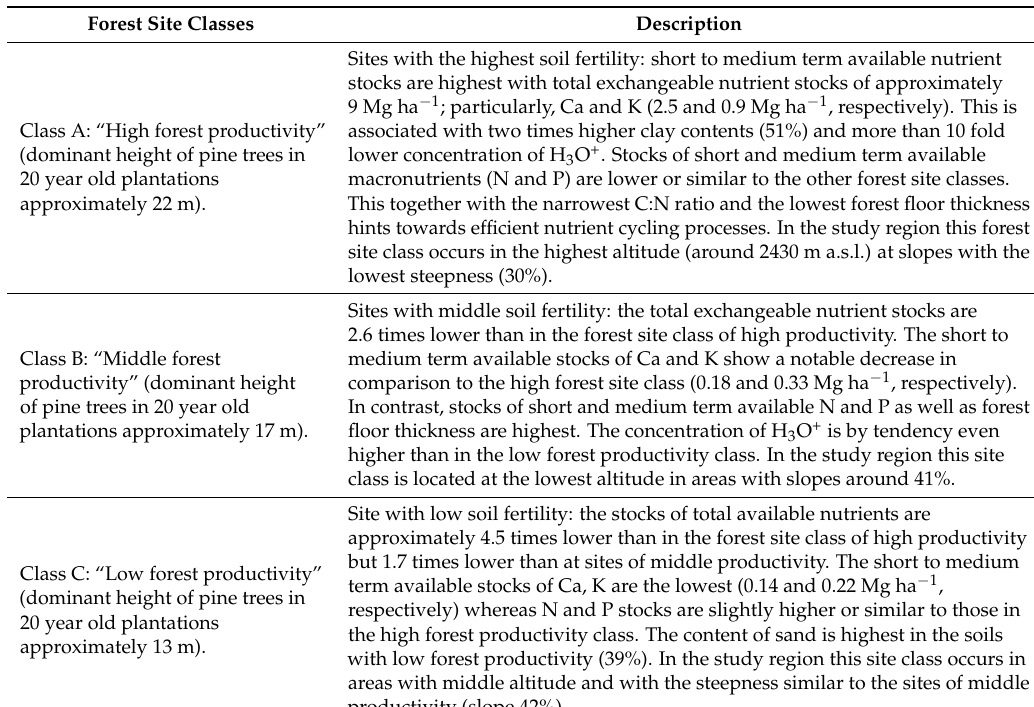
Figure 2. Site classification described by the three groups of forest productivity after the cluster analysis (factor map based in two dimensions of the clustering analysis explaining approximately the 43% of the total variability). Cluster analysis was based on analysis of soil, climate, and topographical variables. Cluster of the highest forest productivity = class A; cluster of medium forest productivity = class B; and cluster of the lowest forest productivity = class C. Table 8. Definition of the forest site classes in the study